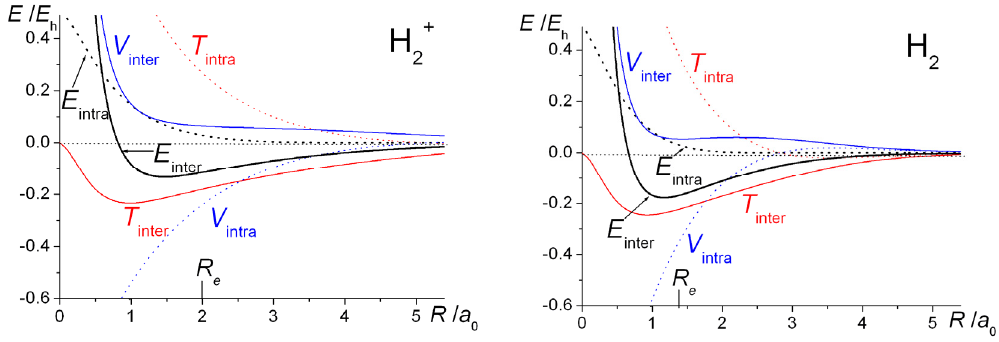
Figure 6. Intra- and interatomic energies of H 2 + and H 2 from molecular wave functions with Figure 6. Intra ‐ and interatomic energies of H 2+ and H 2 from molecular wave functions with optimized ζ optimized  .